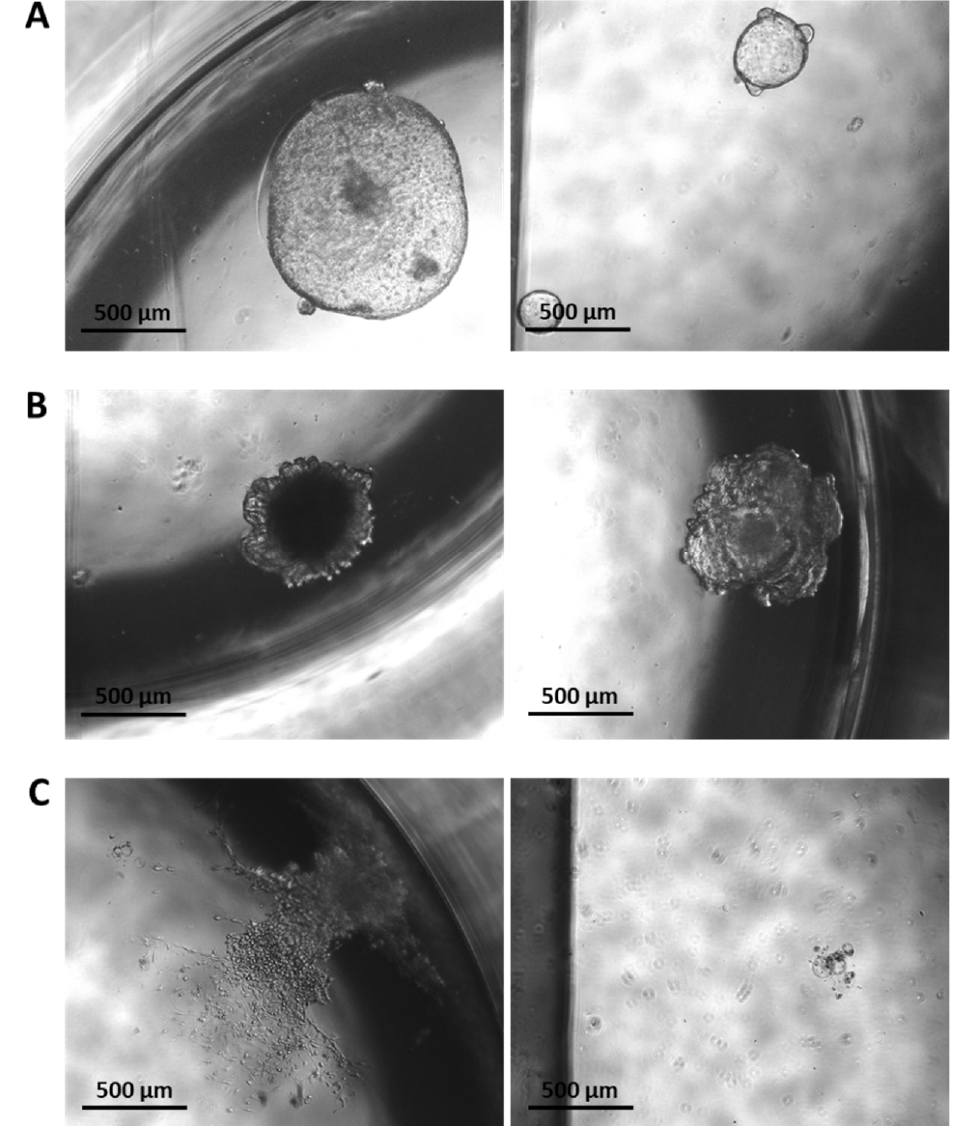
Figure 7. Brightfield microscopy of organoids grown from single tdTomato-positive cells for 11 days. ( A ) Cystic organoids grown from single Cdh1 +/+ cells. ( B ) Organoids grown from single Cdh1 − / − cells with a relatively disrupted structure. ( C ) Most single Cdh1 − / − cells failed to generate organoids, instead presenting with mesenchymal-like (left) or signet ring cell-like (right) morphologies. In the gastric organoid model of HDGC, both the sphingosine kinase 1 inhibitor PF- 543 and the c-Src/Fyn kinase inhibitor PP1 preferentially inhibited the growth of Cdh1 fl/fl organoids across all assessed concentrations (Figure 9, Tables S14 and S15). Chlorpromazine induced a synthetic lethal effect at 6.25 µ M but was highly toxic to both organoids at greater concentrations (Figure 9, Tables S14 and S15). Chloroquine induced a synthetic lethal effect at both 12.5 µ M and 25 µ M but was also highly toxic regardless of Cdh1 status at 50 µ M (Figure 9, Tables S14 and